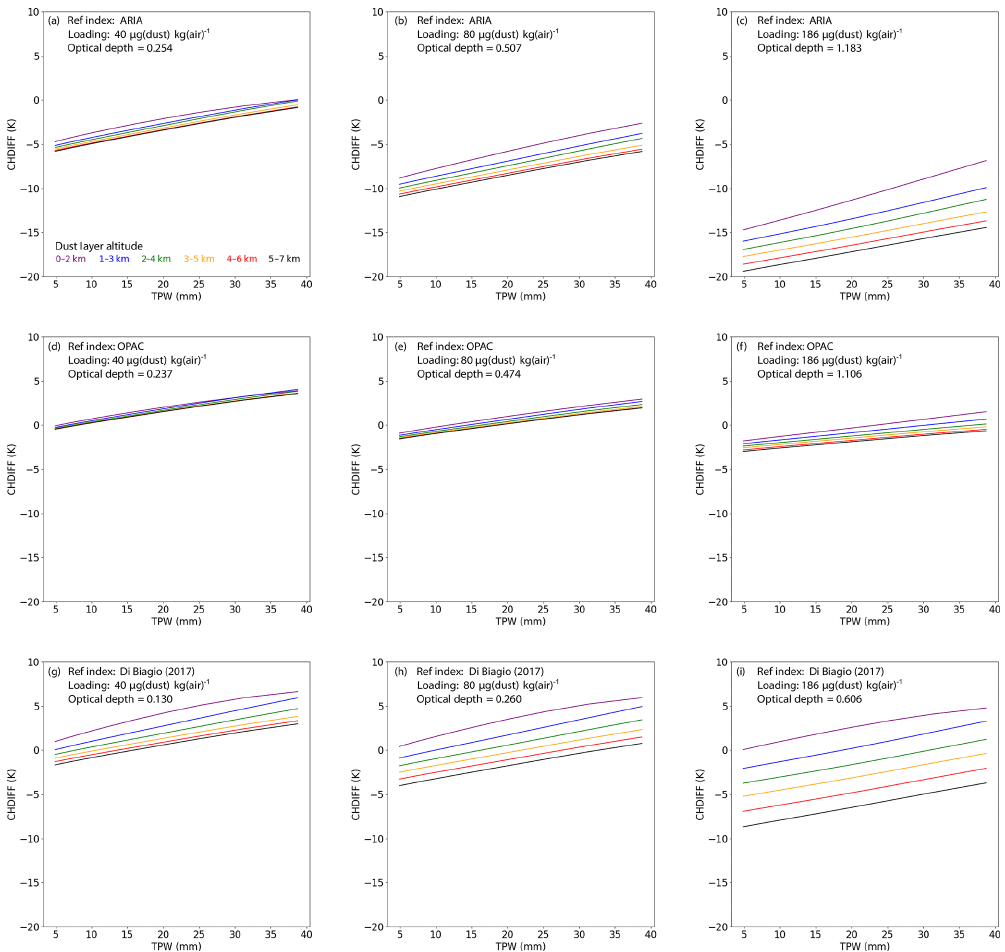
Figure 12. Same as Fig. 11 but comparing the ARIA (a–c) , OPAC (d–f) , and Di Biagio (2017) (g–i) refractive index databases for common assumptions of dust